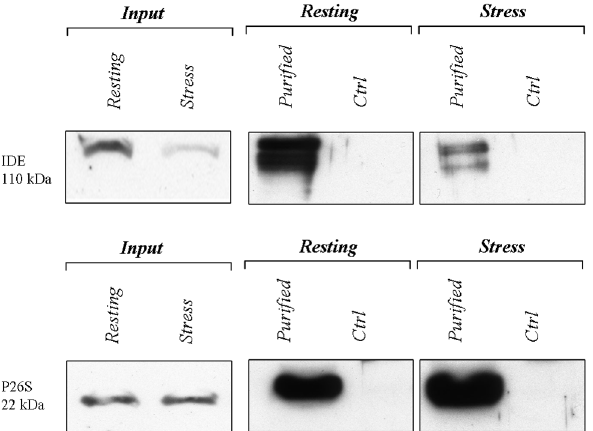
Fig 7. Decreased IDE-proteasome interaction during the HSR. A semi-quantitative comparison of IDE association with the proteasome by Western blotting. Membranes were stained with an anti-IDE antibody (upper panel) and with an anti-protesaome (p27 subunit) antibody (lower panel). Input, stands for 5 micrograms of cytosolic extract loaded in the gel, whereas Ctrl stands for incubation of cell lysates with non- specific beads. A representative immunoblot of three independent experiment is shown. Proteasome particles from the cytosolic fraction of resting and heat-stressed SHSY5Y were affinity purified. Notably, a lower molecular weight species is recognized by the anti-IDE antiboby. Anyway, we are unsure about the identity of this band which, anyway, is constantly observed by us and by other authors when large amount of cell extracts is